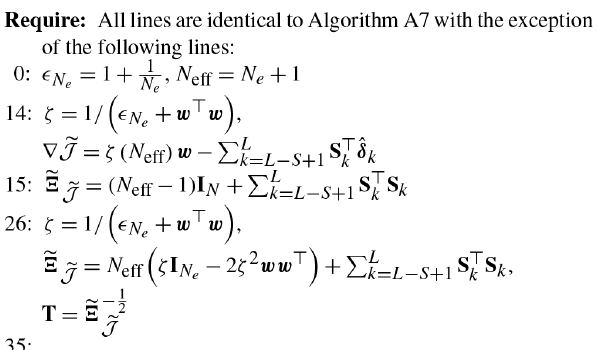
Algorithm A11 Gauss–Newton IEnKS-N in the SDA trans- form